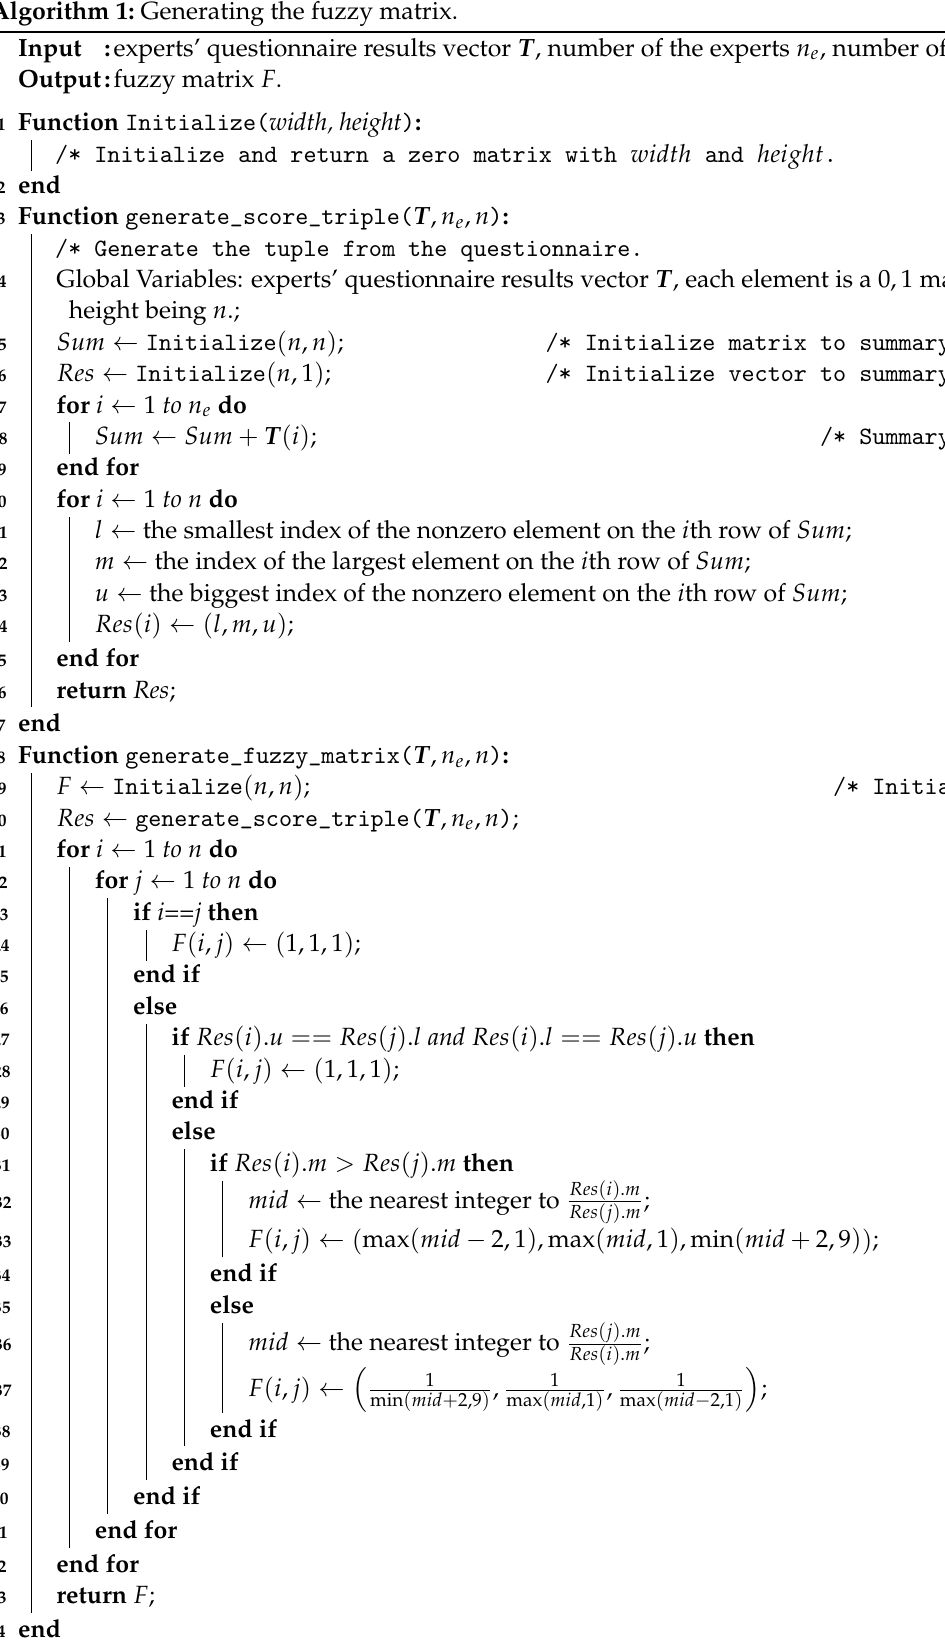
Algorithm 1: Generating the fuzzy